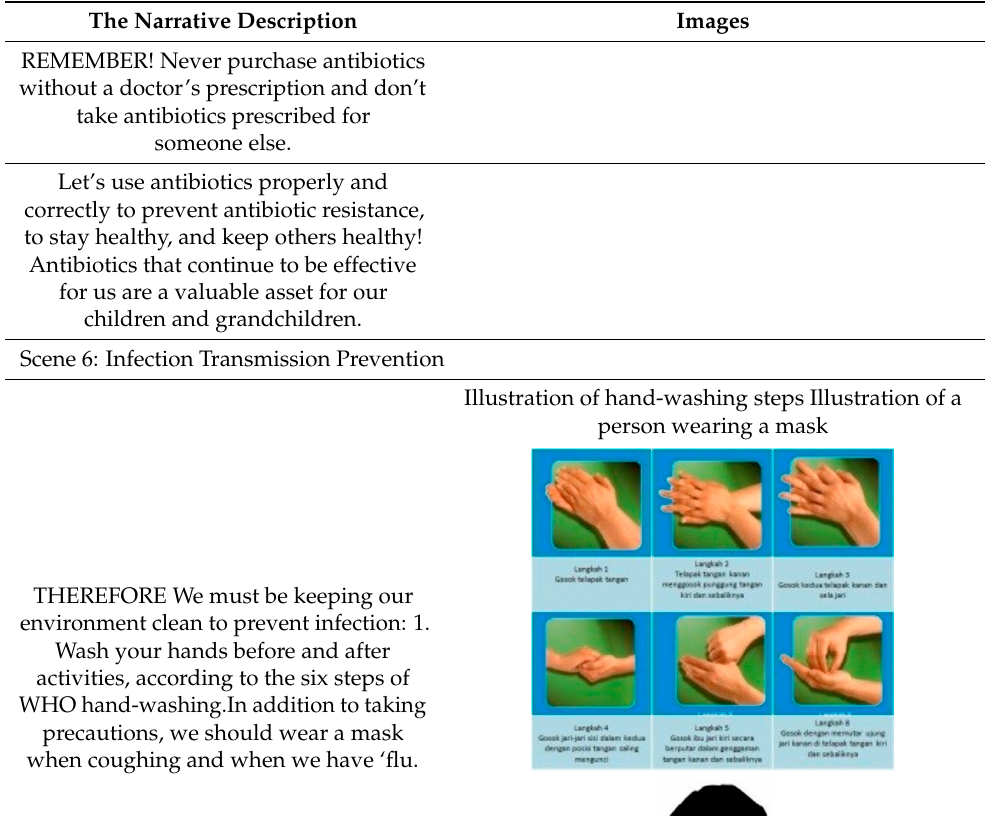
Table A2. Cont. The Narrative Description Images